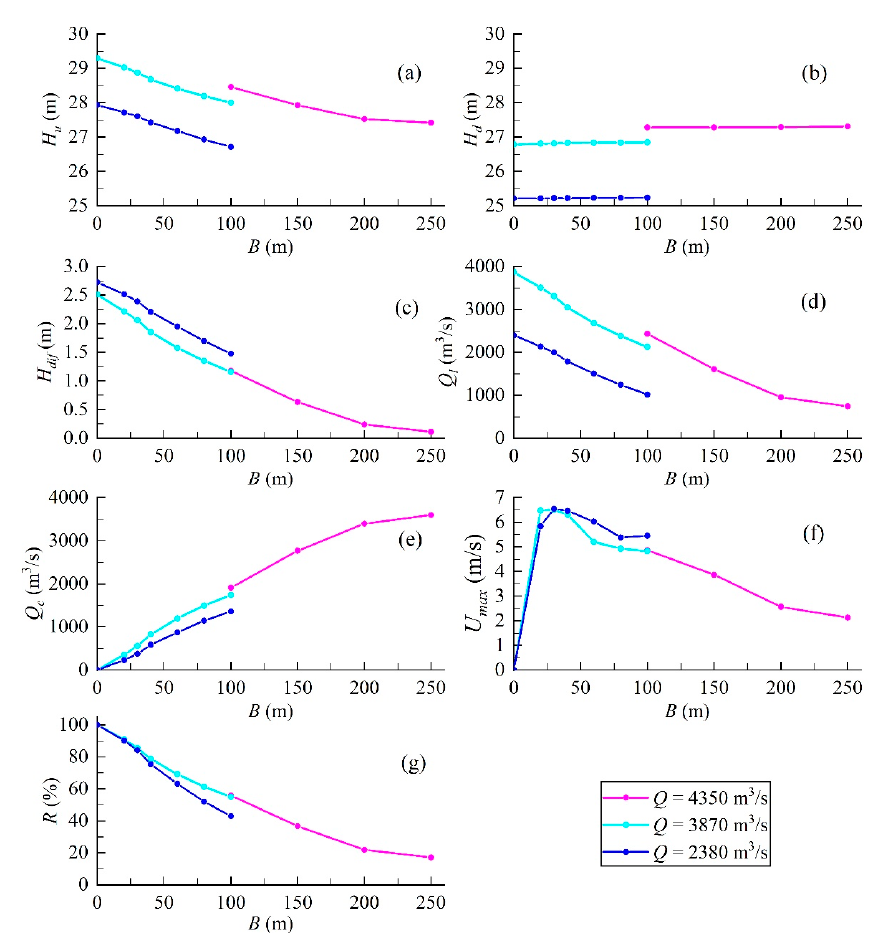
Figure 12. Numerical results of original scheme 1: ( a ) upstream water level; ( b ) downstream water level; ( c ) water level difference; ( d ) flow rate of low holes; ( e ) flow rate of closure gap; ( f ) maximum velocity; ( g ) split flow rate.